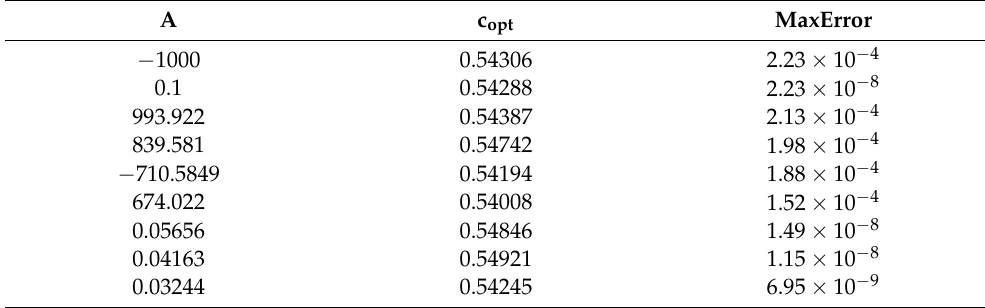
Table 5. Partial results of A ∈ [ − 1000,1000 ] or A ∈ [ − 0.1,0.1 ] .